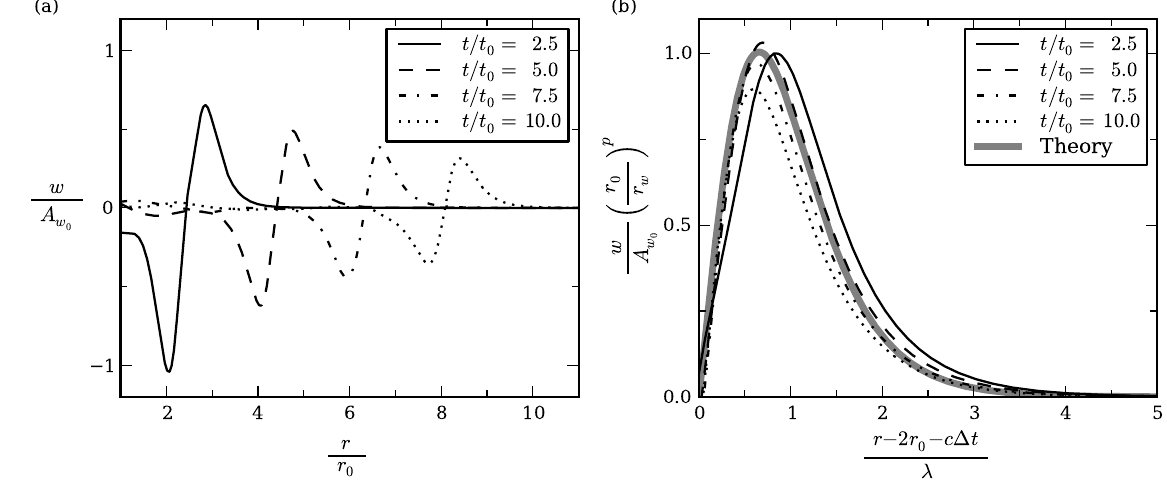
Fig. 7. (a) Horizontal profiles of the vertical velocity field at a height z/H = 0 . 15. (b) Corresponding normalized and shifted profiles, where 1t is the time elapsed since r w = 2 r 0 , p =− 1